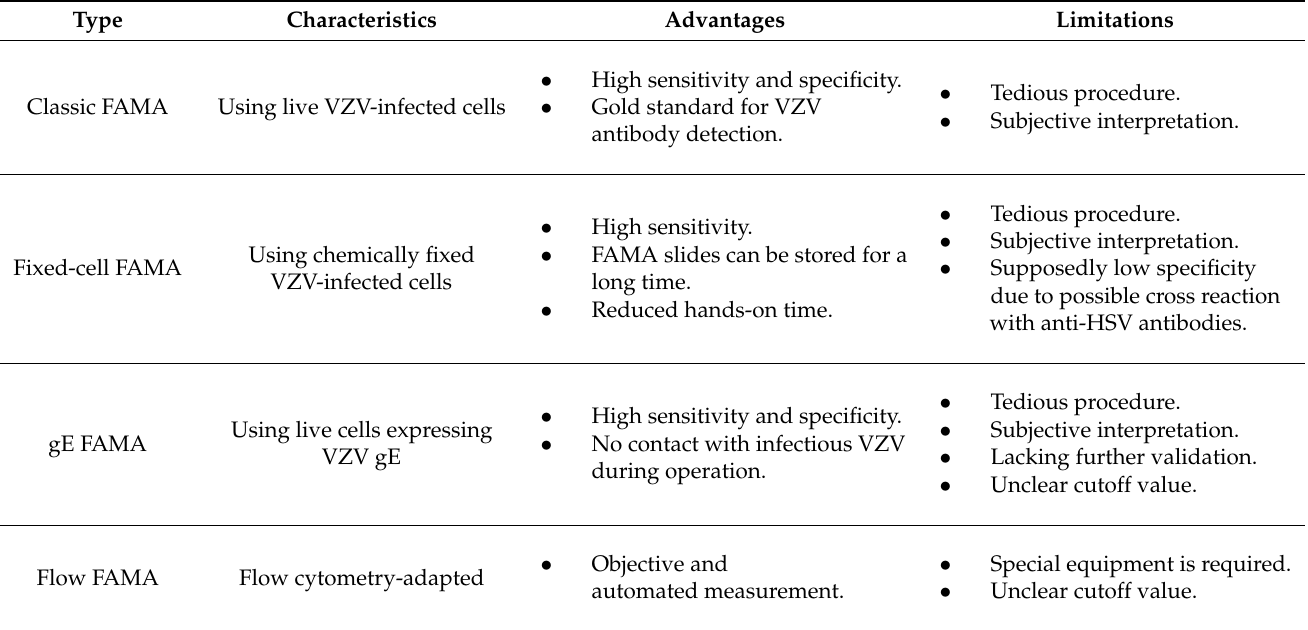
Table 1. Comparison of four types of FAMA tests for detecting anti-VZV